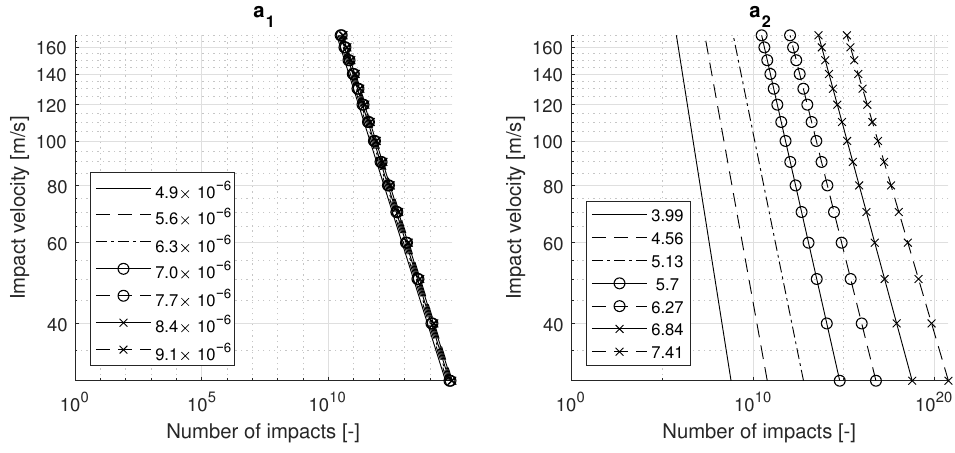
Figure 6. VN curves for variations in a 1 ( left ) and a 2 ( right ) for TPUA80. The average sensitivity for the materials defined in Table 2 was determined in order to perform a global sensitivity analysis. The results can be found in Figure 7. This figure shows the predicted lifetime and the sensitivity, i.e., the change in lifetime for a variation of 0.01% in an input parameter. It can be seen that a change in Poisson ratio has a large effect on the predicted lifetimes for elastomeric materials, e.g., isoprene, ebonite and